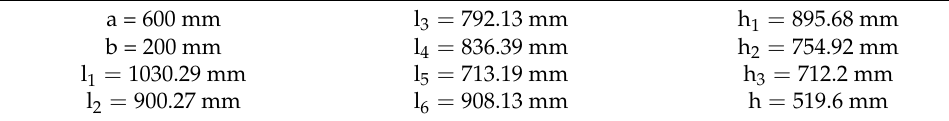
Table 1. The physical parameters of the SP.